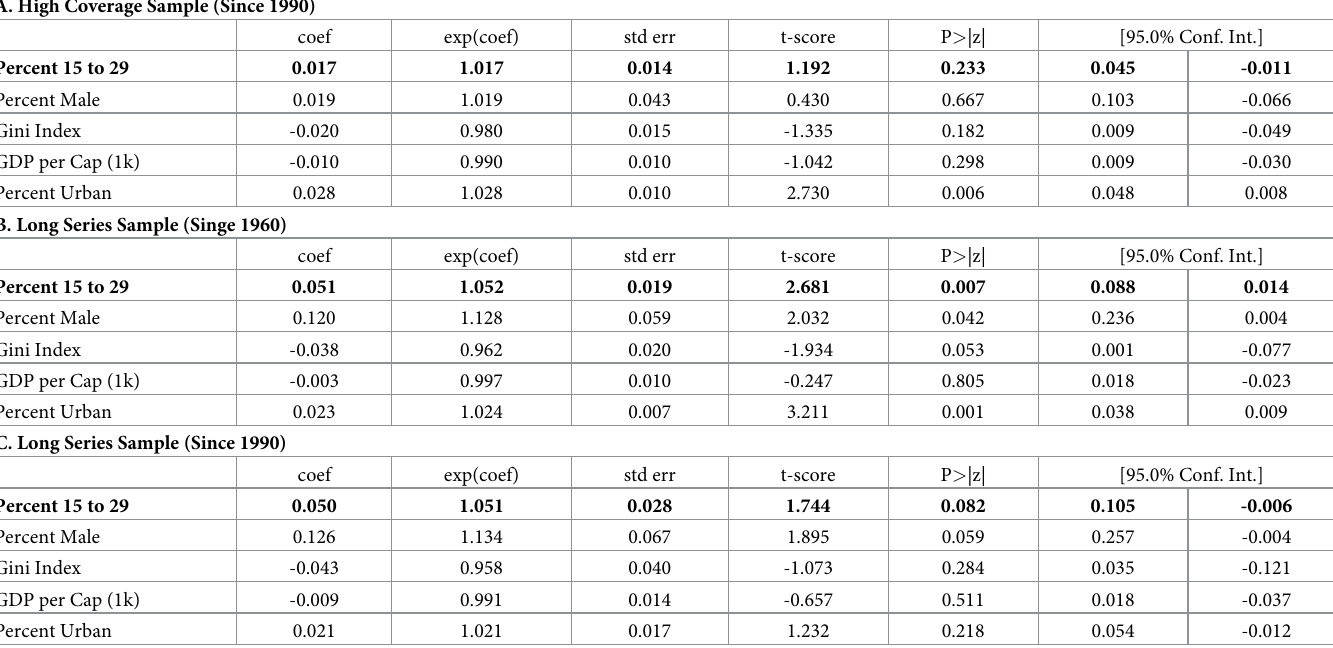
Table 2. Two-way fixed effects (country and year) models for the average effect of percent 15 to 29 on (ln) homicide rate. A. High Coverage Sample (Since 1990)